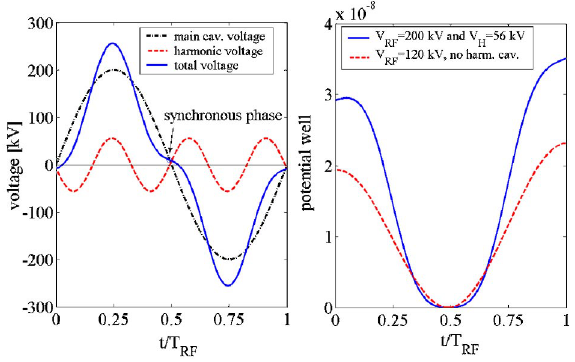
FIG. 1. (Color) Total rf voltage and potential well.